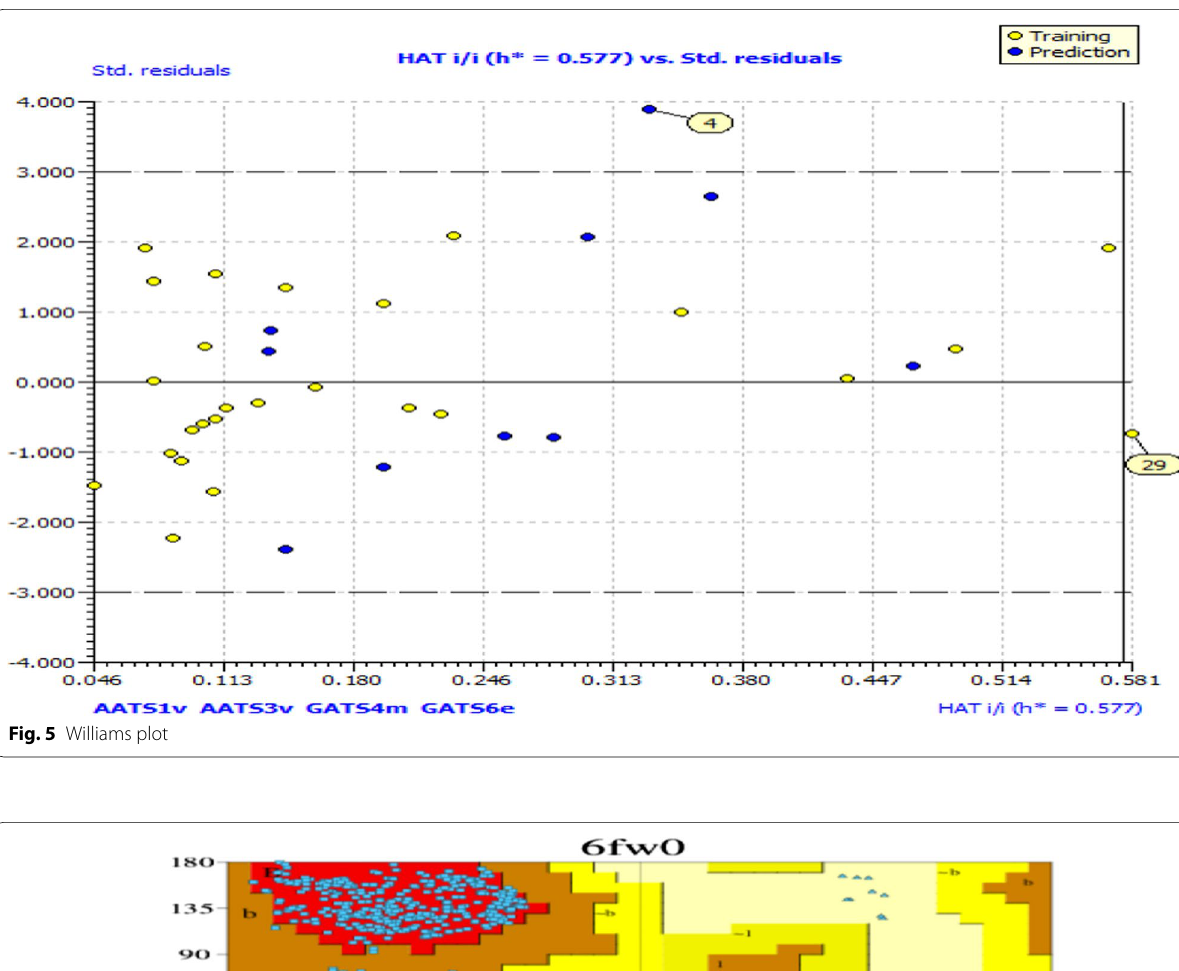
Fig. 6 Ramachandran graph. Most favored region (red), additional allowed region (brown). Generously allowed region (deep